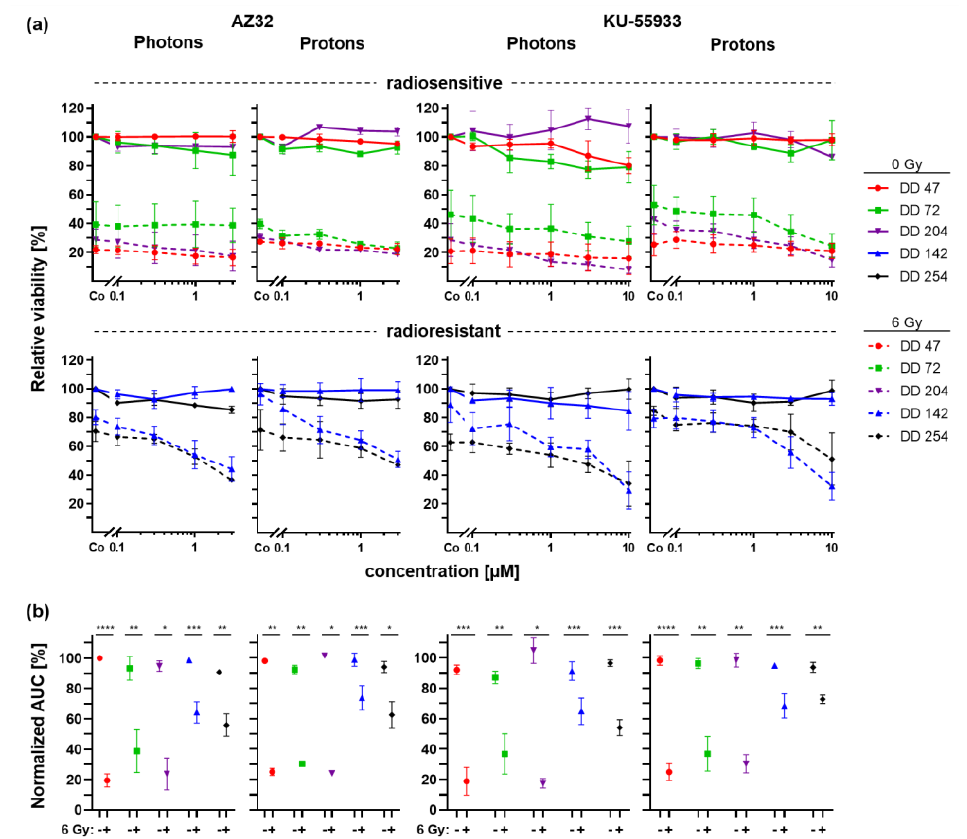
Figure 6. Radiation combined with ATM inhibitor treatment of CRC PDOs. ( a ) Dose response curves of radiosensitive (upper panel) and radioresistant (lower panel) CRC PDOs upon control (continuous line) and 6Gy (dashed line) photon and proton treatment with increasing doses of ATM inhibitors AZ32 and KU-55933. ( b ) Normalized AUCs were calculated. *: p ≤ 0.05, **: p ≤ 0.01, ***: p ≤ 0.001, ****: p ≤